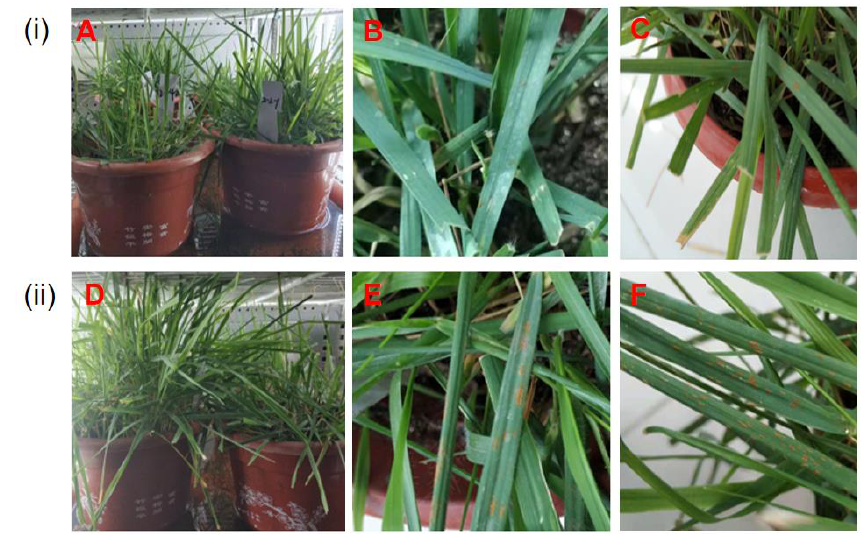
Figure 1. Observation on the leaves of rust-resistant Z. japonica (RR) ( A – C ) and rust-susceptible Z. japonica (RS) ( D – F ) after inoculation with P. zoysiae . ( i ) Inoculated RR leaves; ( ii ) Inoculated RS leaves; ( A , D ) Non-inoculation; ( B , E ) 5 days post inoculation (dpi); ( C , F ) 15 dpi.